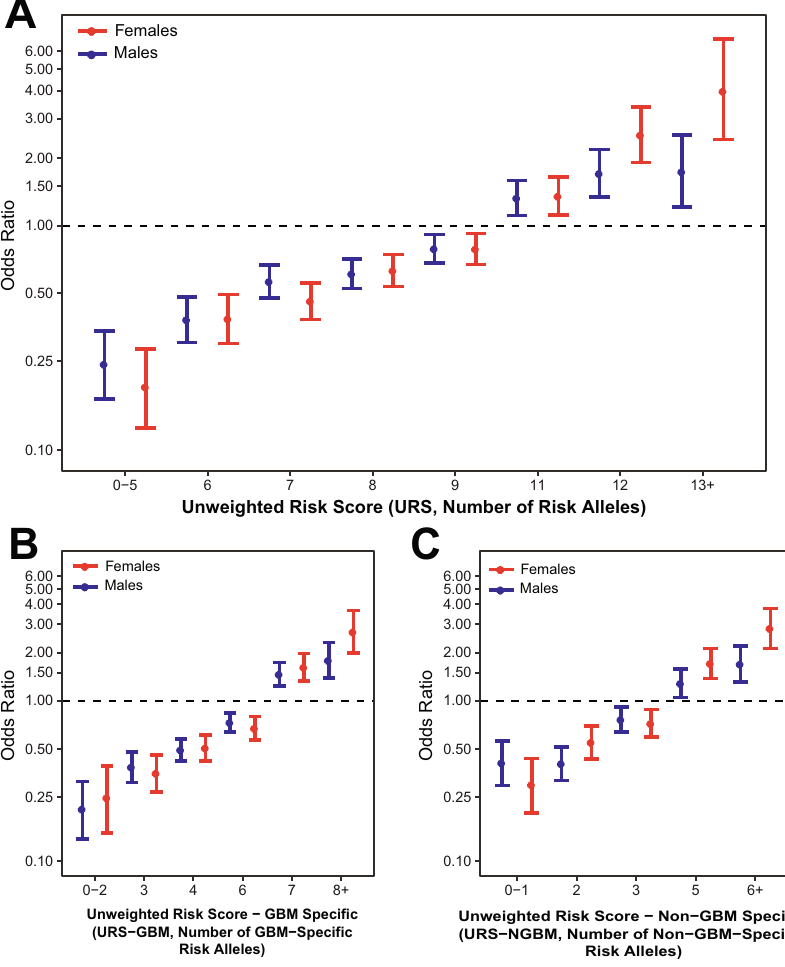
Figure 6. Odds ratios and 95% confidence intervals for unweighted risk (URS) score in ( A ) all glioma, ( B ) GBM-specific URS (URS-G) in GBM, and ( C ) and non-GBM-specific URS (URS-NGBM) for in